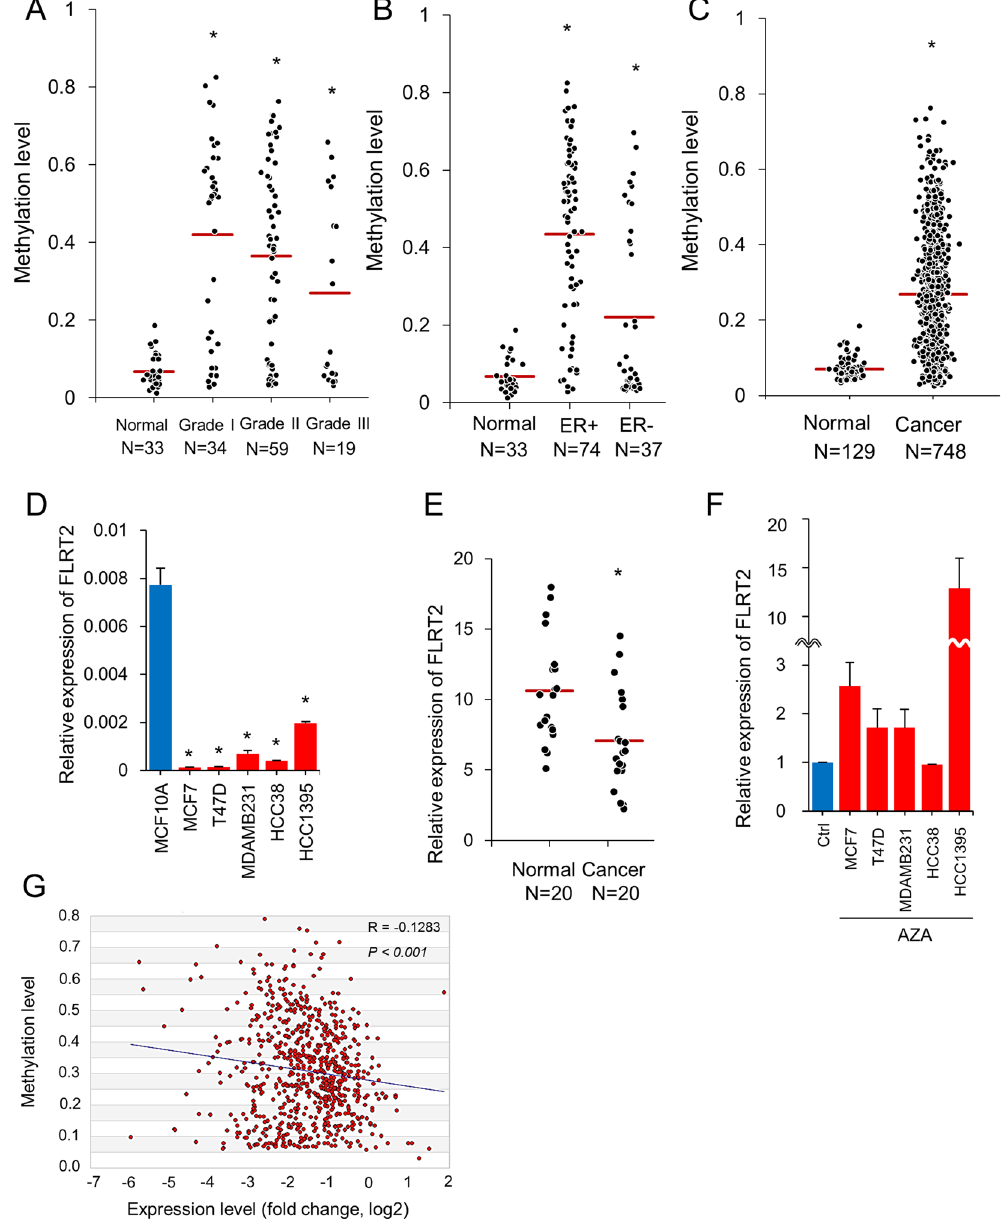
Figure 1. FLRT2 is hypermethylated and downregulated in breast cancer. ( A ) The CpG methylation level of FLRT2 was extracted from the methylation chip data of the GEO (http://www.ncbi.nlm.nih.gov/geo/) ( A , B ) and the TCGA database ( C ). The methylation level was stratified at dot plots according to the cancer grade ( A ) and ER status ( B ) or for the whole cancer samples ( C ). The median value is indicated by a red bar. The expression level of FLRT2 was examined in breast cell lines ( D ) and tissues ( E ) by real-time RT-PCR. MCF-10A is a normal cell line while the others are cancer cell lines. ( F ) Demethylation of CpGs was induced by 5-Aza- 2 ′ -deoxycytidine (AZA) in cancer cell lines and FLRT2 expression was analyzed by real-time RT-PCR. All RT- PCR experiments were carried out in triplicate and the data are represented as mean ± SD. ( G ) Association of methylation and expression in breast cancer tissue was plotted for 713 samples from the TCGA database (http:// cancergenome.nih.gov/) ( P <